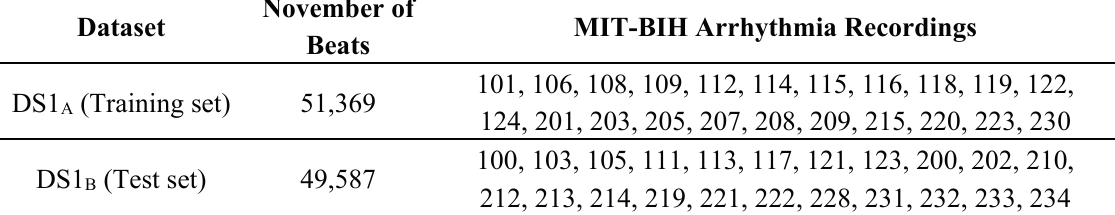
Table 9. Separating training and test datasets in